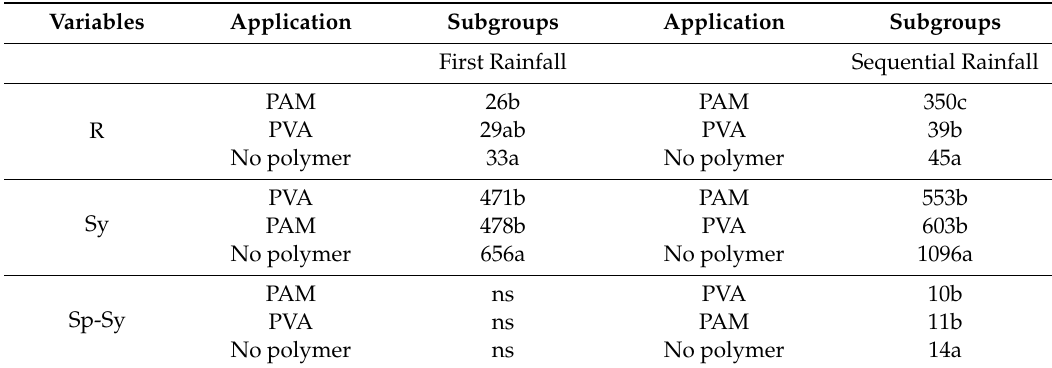
Table 5. Duncan test results through the applications ( α =